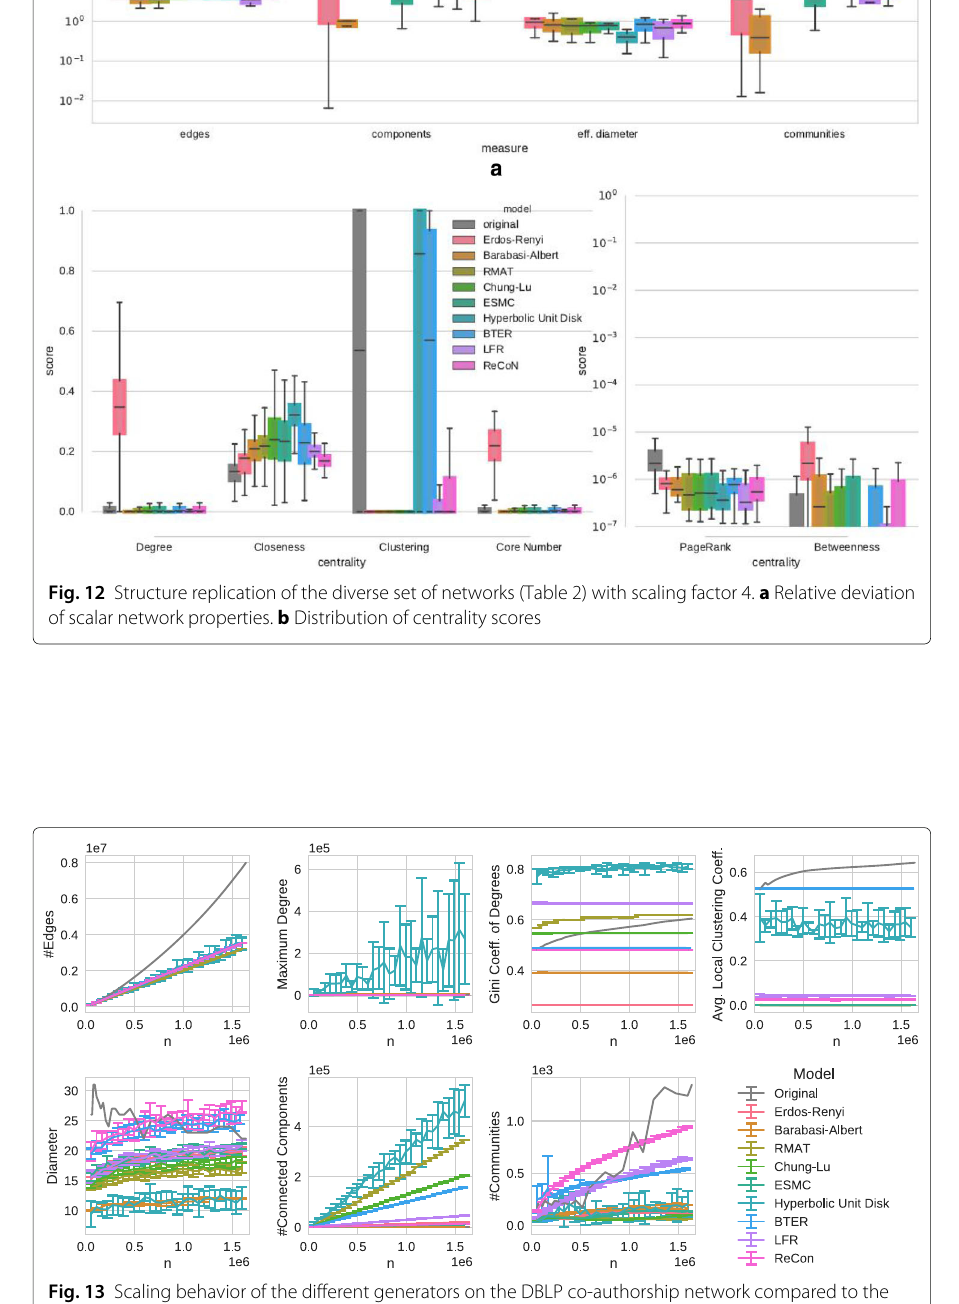
Fig. 13 Scaling behavior of the different generators on the DBLP co-authorship network compared to the behavior of the original network over time. From left to right and top to bottom: number of edges, max. degree, Gini coefficient of the degree distribution, average local clustering coefficient, diameter, number of connected components, number of